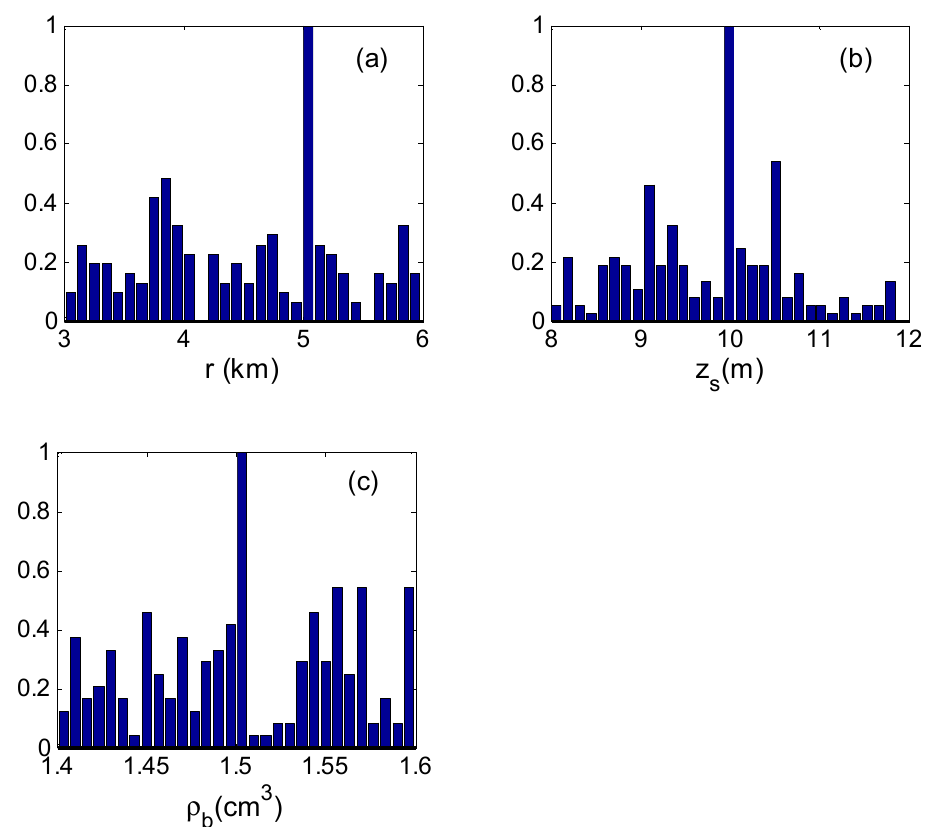
Figure 13. Marginal probability densities from Bayesian inversion: ( a ) the source range; ( b ) the source depth; ( c ) the seabed density.